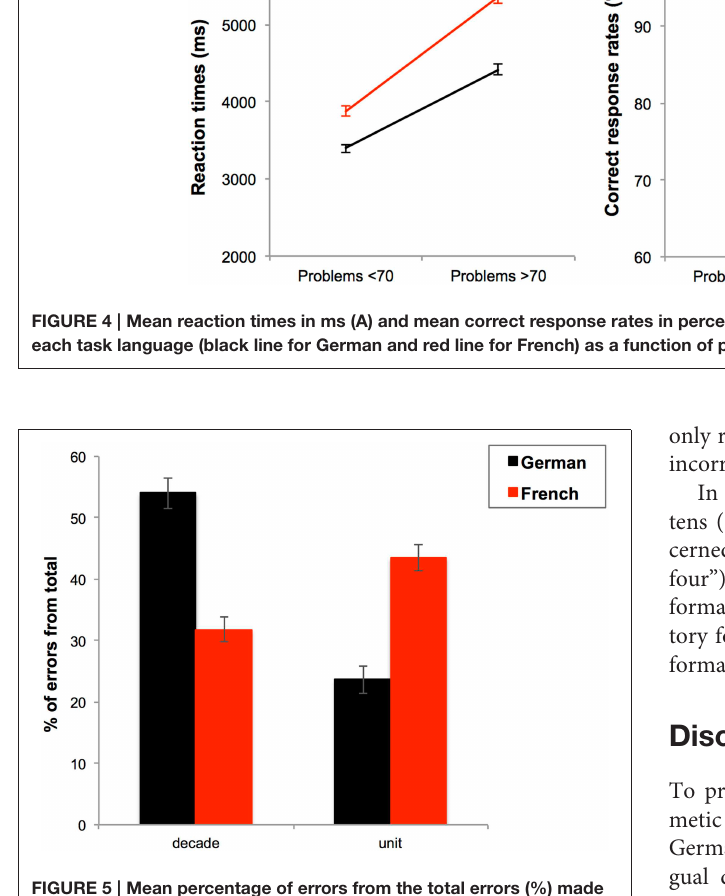
FIGURE 5 | Mean percentage of errors from the total errors (%) made on the decade digit or on the unit digit with standard errors for each task language (German in black and French in red). Bars represent standard